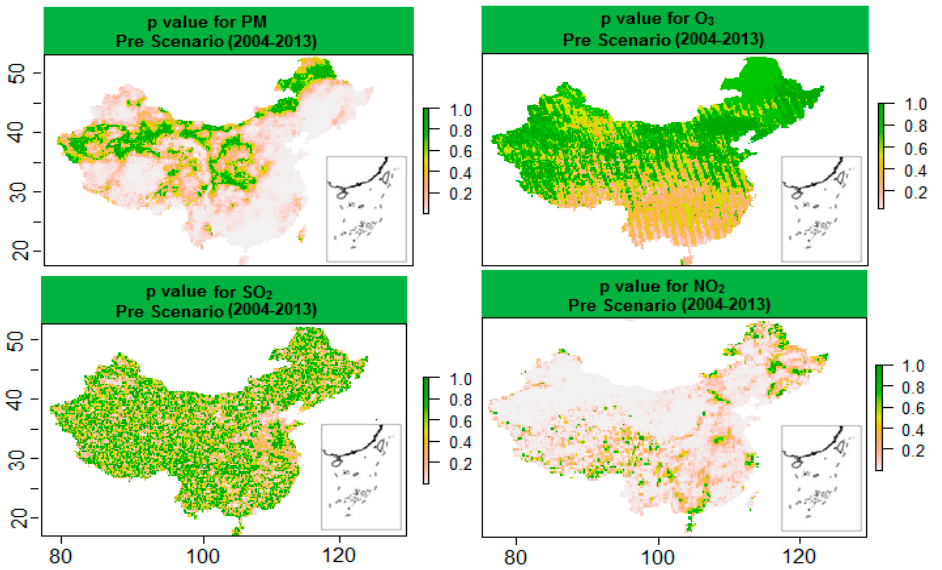
Figure 5. p Value of air pollutants for the pre-scenario period (2004–2013). Note: Mann Kendall p value at 95% confidence ( p < 0.05).